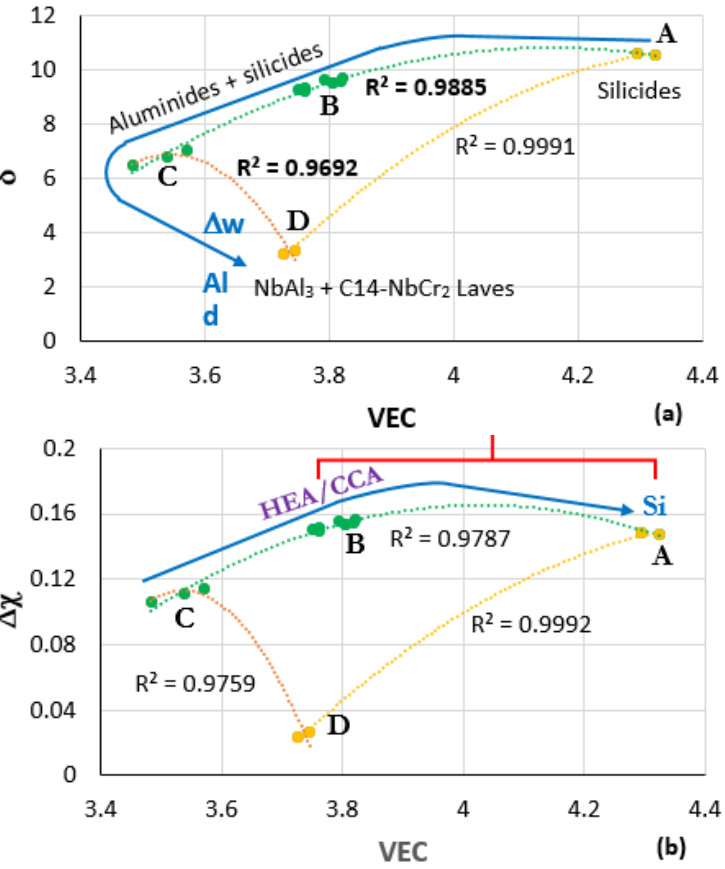
Figure 8. Maps of the parameters δ , Δ χ , and VEC with data for the alloys OHC5 [39], MG5, MG6, MG7 [11,22], Zone A of MG7 [11] and OHC3 [10]. In the maps, A corresponds to OHC5, B to MG5, MG6, MG7, C to Zone A of MG7, and D to OHC3. The microstructures in different areas of the maps and the “direction” of increase in Al concentration, mass change per unit area ( Δ w) and oxide scale thickness (d) are shown in ( a ). The area where alloys could be considered as HEA or CCA and the direction of increase of Si concentration in the map are shown in ( b ). The area where the oxidation rate constants of the BC alloys are in the range of NiAl and Ni-Cr-Al alloys at 1200 °C is shown with the red bracket in ( b ).